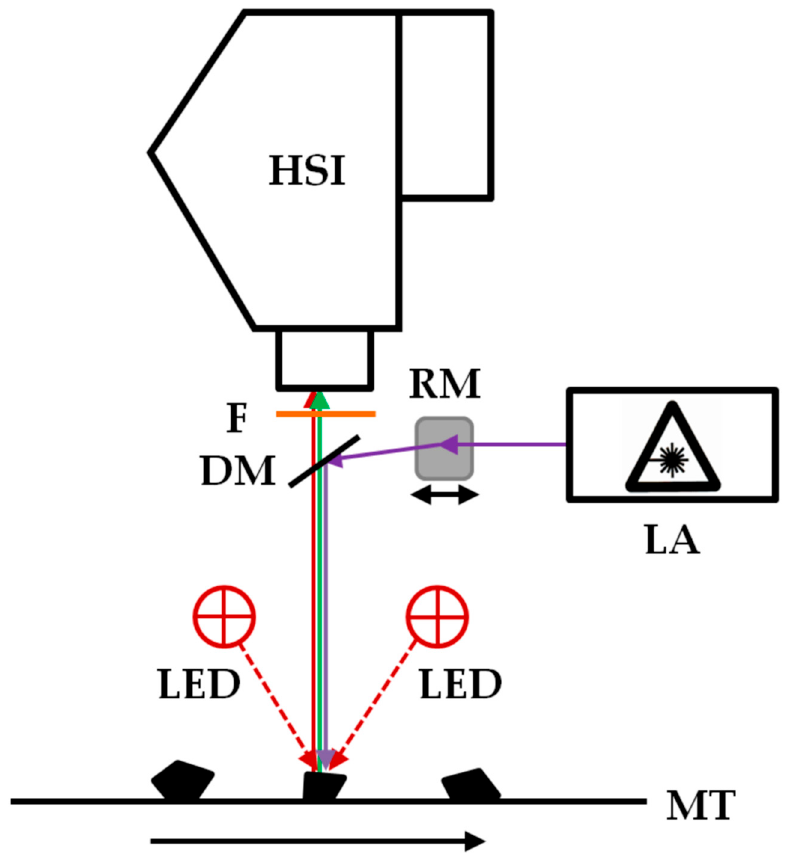
Figure 1. Schematic representation of the imaging fluorescence spectrometer for the classification of black plastics. HSI: visible and near-infrared HSI camera. DM: Dichroic mirror. LED: near-infrared LEDs λ = 870 nm. F: Long pass filter. GM: Rotating mirror. LA: Excitation laser. MT: motion unit.